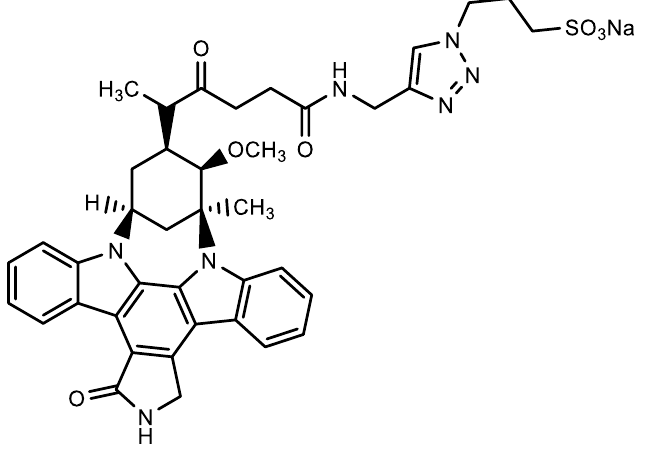
Figure 6. Structure of CIMSSNa ( 10 ) .